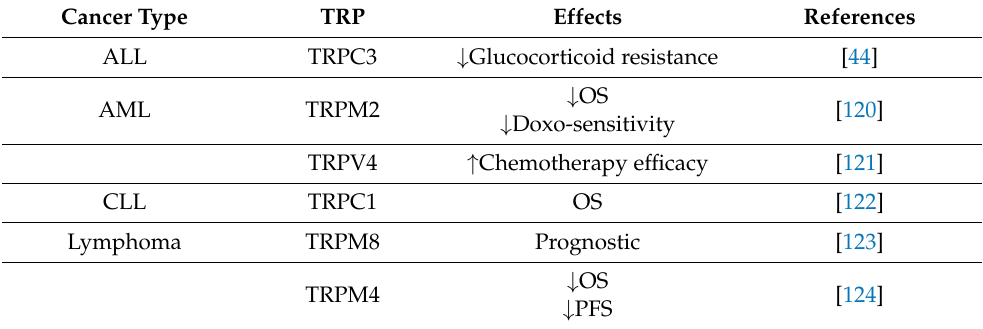
Table 3. Expression and functions of TRP channels in leukaemia and lymphoma